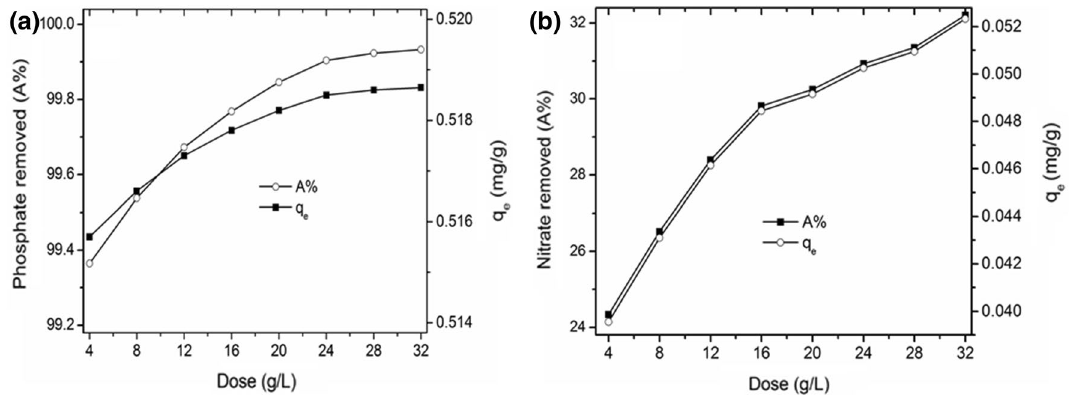
Fig. 3 Effect of adsorbent dose on the simultaneous removal of a phosphate and b nitrate